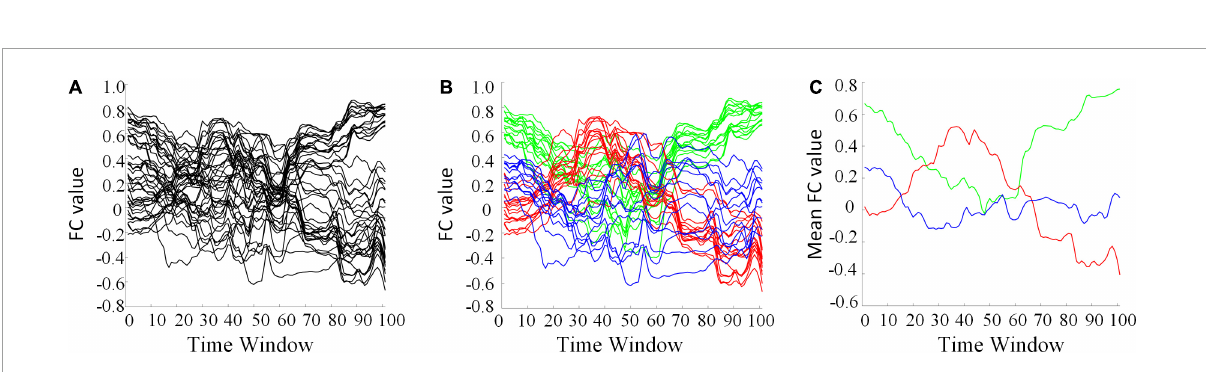
FIGURE6 Some selected FC series and their clustering results ( L = 40, U = 600). (A) The original FC series. (B) Red, green, and blue indicate three different clusters. (C) The averaged FC series of the three clusters, separately.